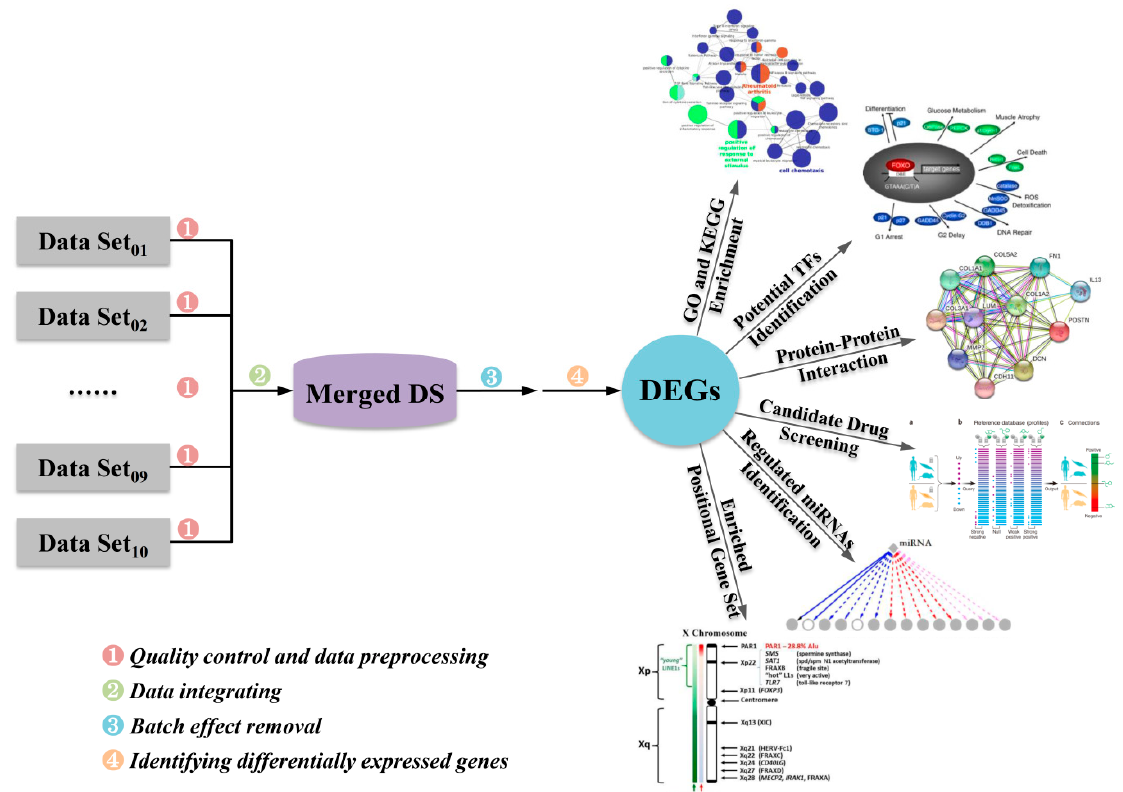
Figure 1. The workflow of microarray data integration and subsequent analyses in this study. Quality control of each dataset was manually checked, and then 10 preprocessed and independent qualifying datasets were merged into a large dataset (designated as Merged DS) for further analysis. Batch effects were removed by using the algorithm of batch effect removal. Differentially expressed genes (DEGs) between the asthmatics and healthy controls were identified based on expression fold change > 1.2 and false discovery rate (FDR) < 0.05. Gene ontology (GO) and Kyoto Encyclopedia of Genes and Genomes (KEGG)-based pathways were subsequently enriched and followed by protein-protein interaction (PPI) network construction, prediction of potential transcription factors (TFs) and microRNAs, chromosomal